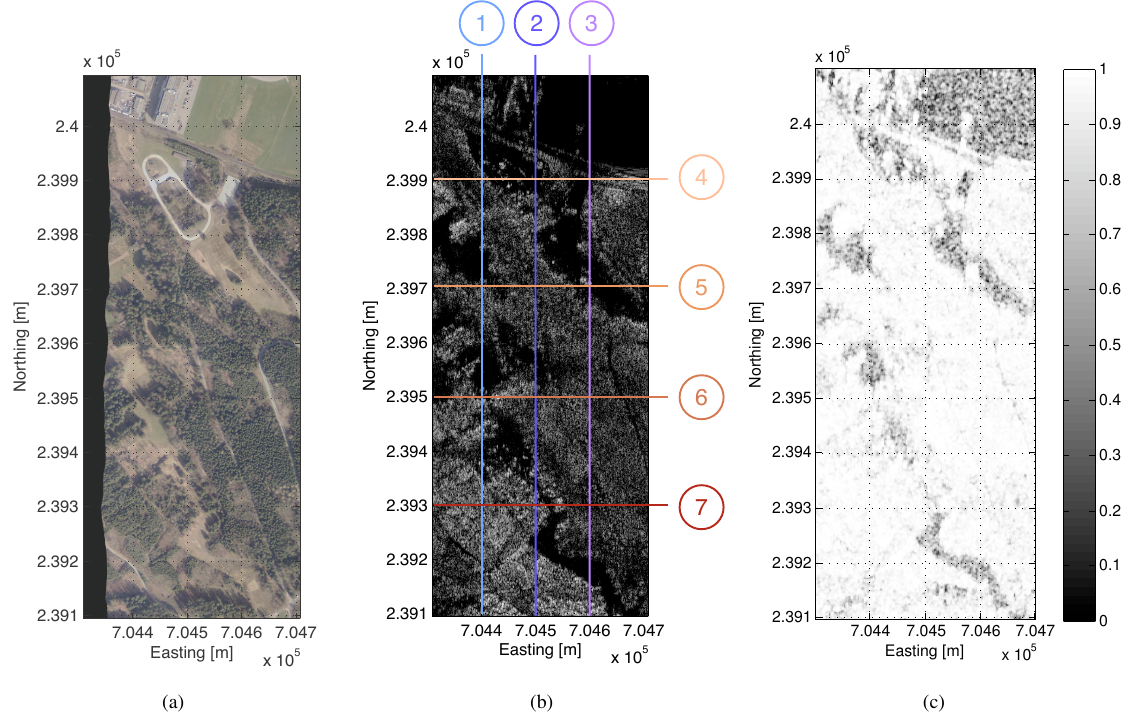
Figure 4. (a) RGB ortho-image of the partially forested area selected for tomographic imag- ing taken at the time of acquisition of the reference DEM/DSM data sets by airborne laser scanning (Falcon II, TopoSys GmbH), (b) SAR intensity values within a horizontal tomo- graphic slice of the reconstruction grid on the height level H = 551 m. (c) Coherence map of the zero baseline configuration (track no. 1 and track no.